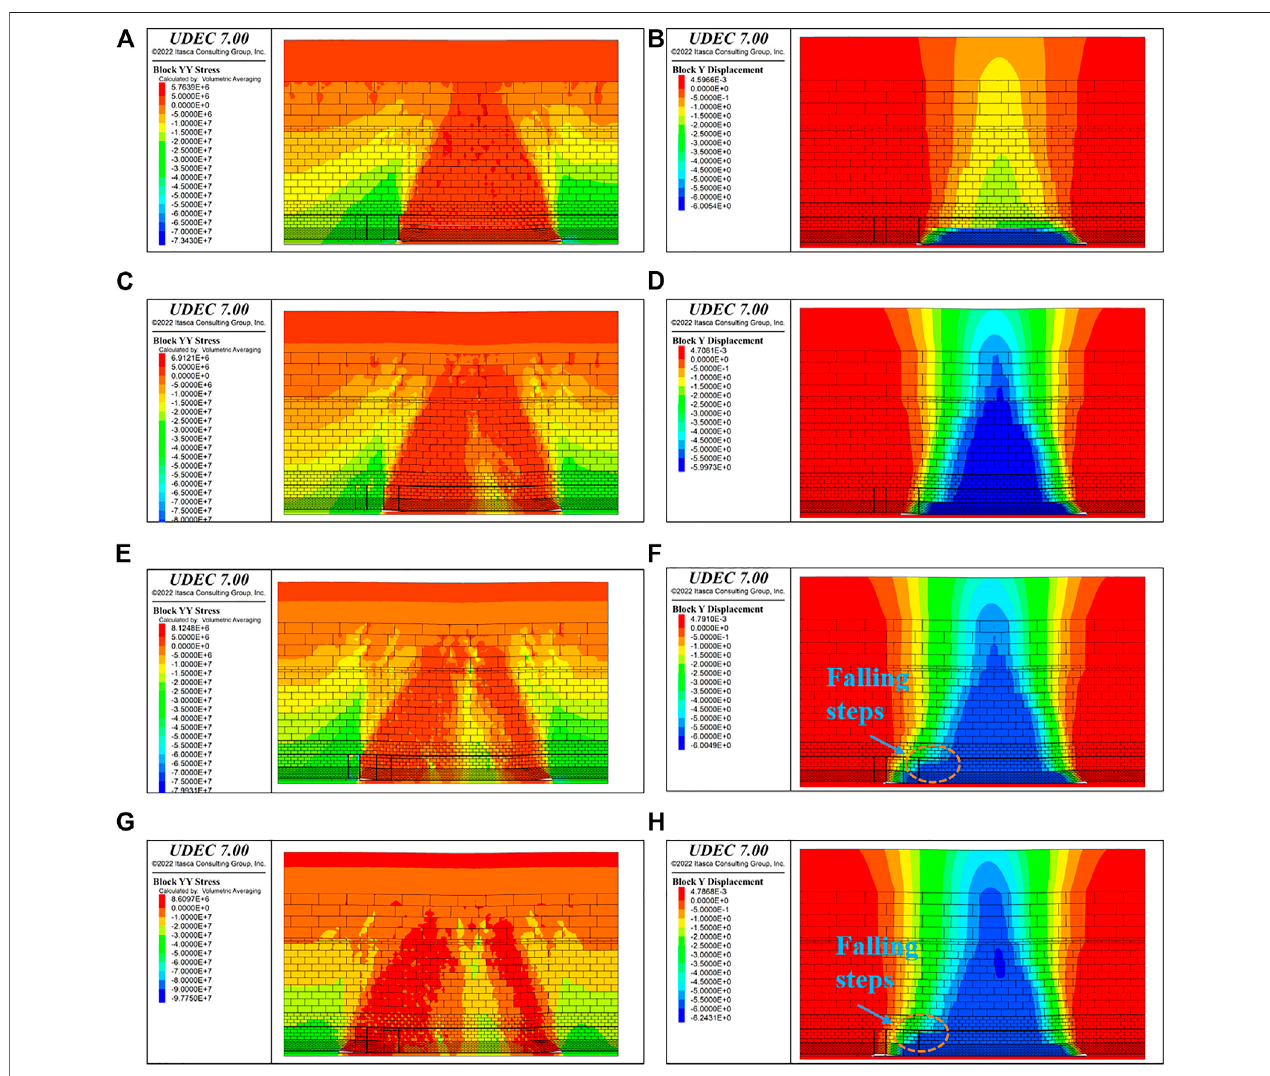
FIGURE 9 | Stress and displacement nephograms of deep-hole blasting (+ represents the tensile stress, - represents compressive stress): (A) the stress nephogram after the 1st blasting; (B) the displacement nephogram after the 1st blasting; (C) the stress nephogram after the 2nd blasting; (D) the displacement nephogramafterthe2ndblasting; (E) thestressnephogramafterthe3rdblasting; (F) thedisplacementnephogramafterthe3rdblasting; (G) thestressnephogramafter the 4th blasting; and (H) the displacement nephogram after the 4th blasting.